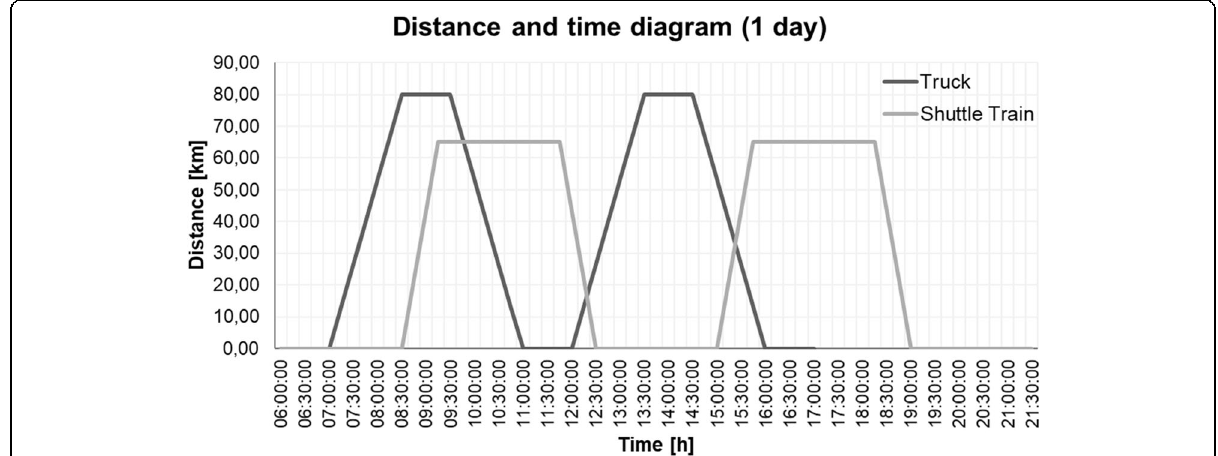
Fig. 16 Diagram of an example of a truck service and a shuttle train service in a day